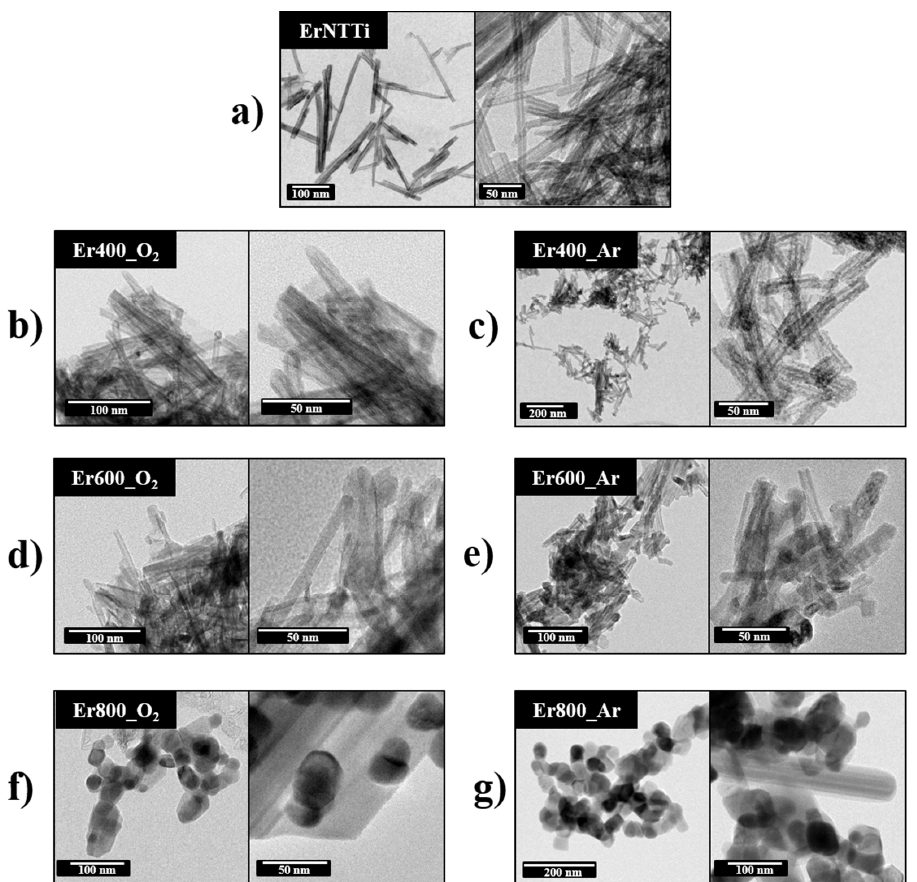
Figure 4. TEM images of ErTiNT without treatment ( a ), ErTiNT treated in air, 400 °C ( b ), 600 °C ( d ), 800 °C ( f ), and treated in Argon, 400 °C ( c ), 600 °C ( e ), 800 °C ( g ), showing the tubular morphology until 400 °C and the collapse of tubes and formation of NPs clusters of TiO 2 anatase.